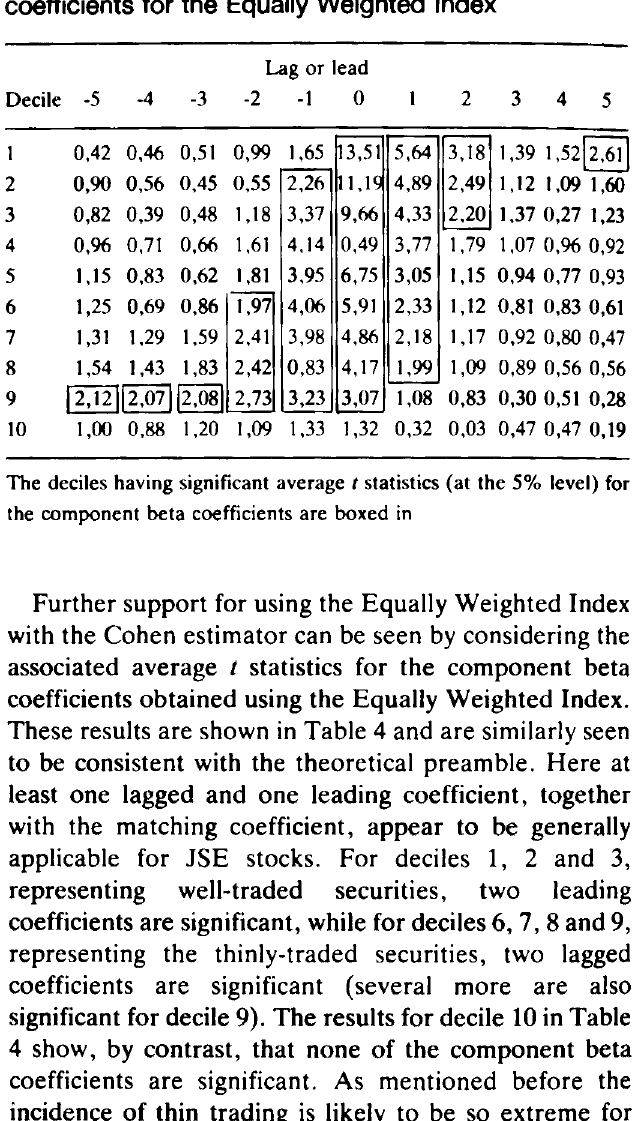
Average component beta coefficients for the Equally Weighted Index Lag or lead